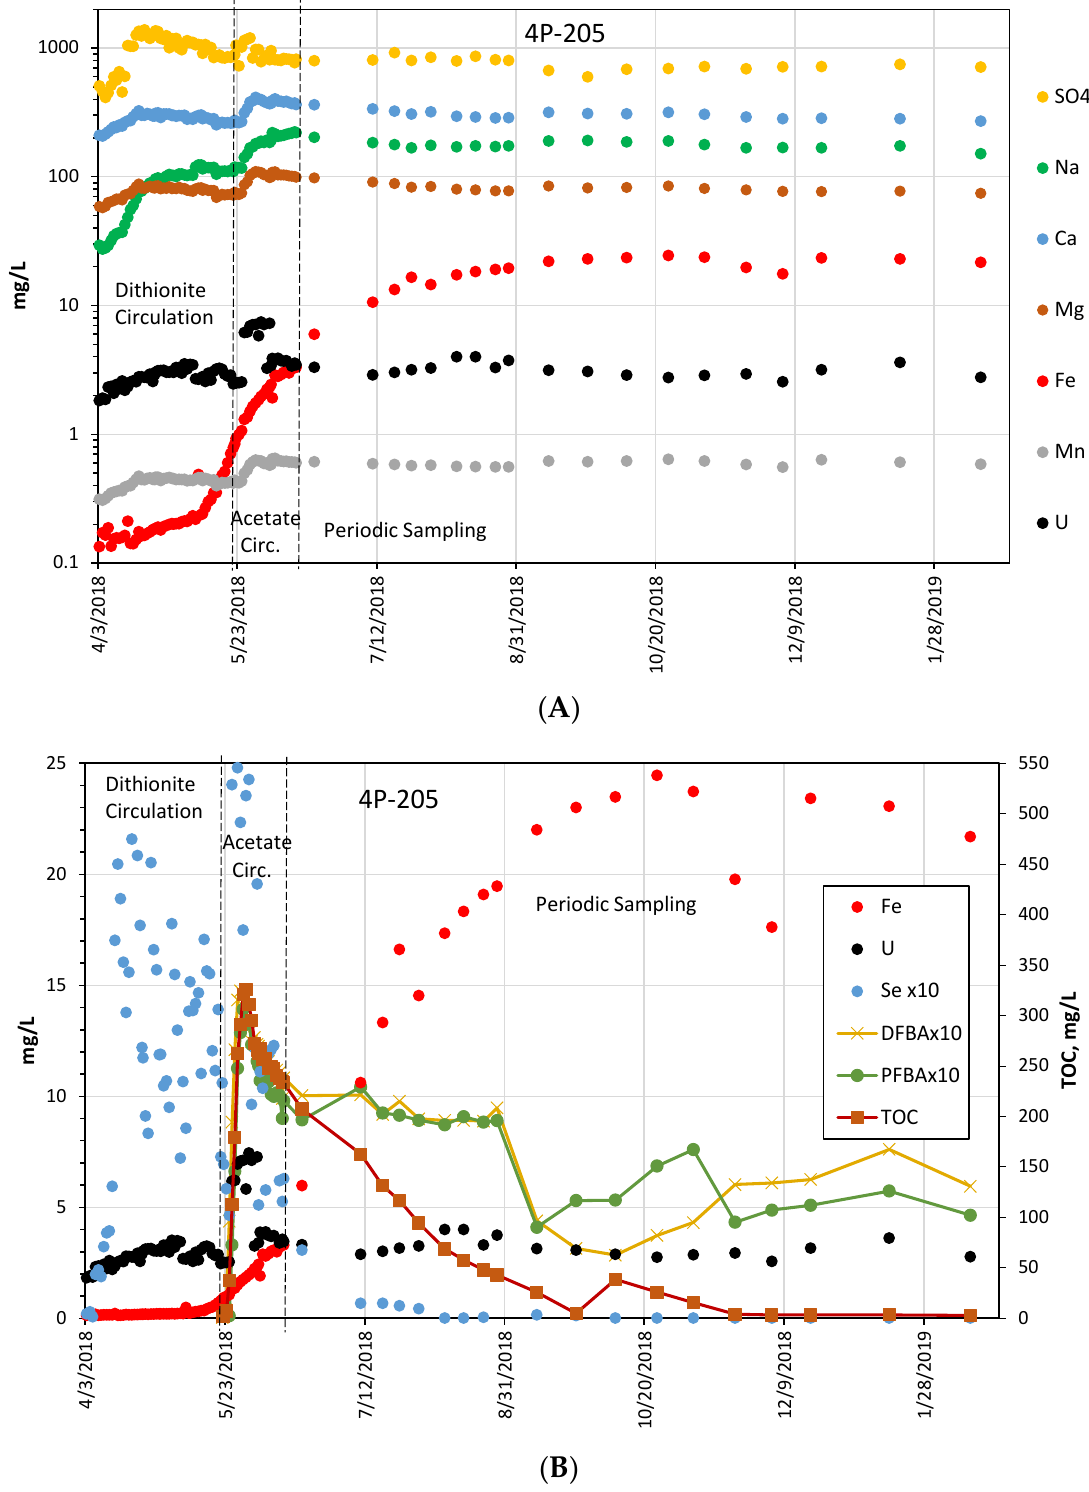
Figure 3. ( A ) Concentration histories of several key constituents in production well 4P-205 during the amendment test. ( B ) Concentration histories of redox-sensitive constituents (Fe(II), U, Se), TOC (as acetate surrogate), and tracers. Note that Se, difluorobenzoate (DFBA), and pentafluorobenzoate (PFBA) concentrations are multiplied by 10.